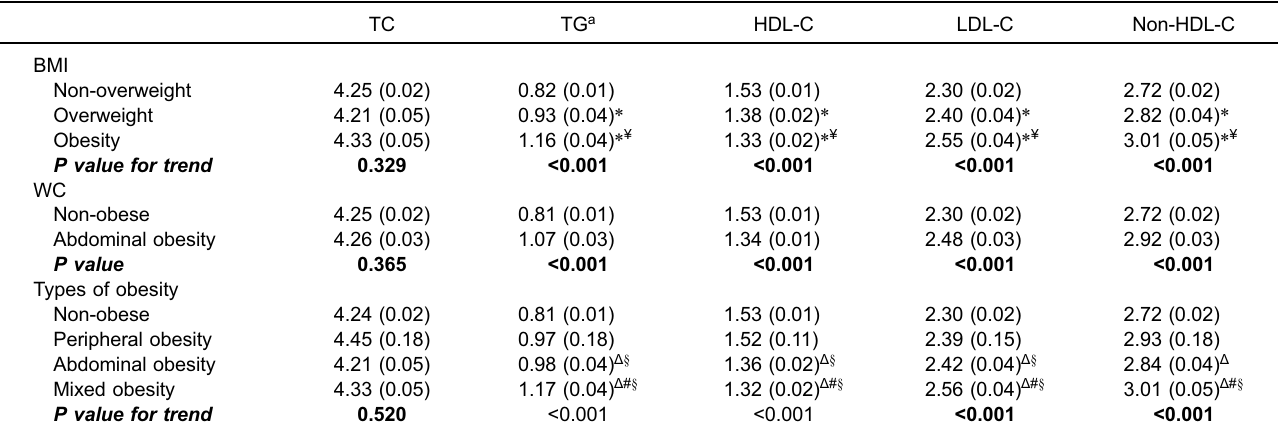
Table 4. Mean serum lipid concentrations among children and adolescents obesity extent and type TC TG a BMI